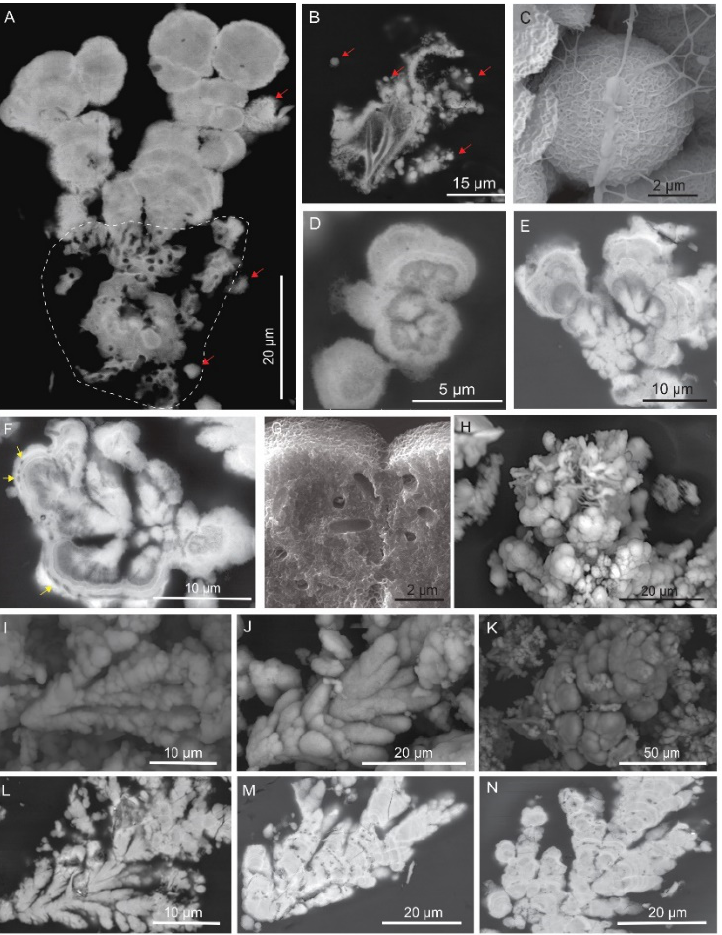
Figure 6. SEM images showing microstructures of the Ytterby rock wall Mn oxides. ( A ) Uncoated polished thin section showing laminated branches of dendritic-botryoidal Mn oxides growing on nucleation area (dashed). ( B ) Uncoated polished thin section of nucleation area showing Mn oxide encrustation of microbial remnants (filaments and cell-like structures) and wad-like Mn oxides occurring as solitary particles and in clusters (red arrows). ( C ) Cryo-SEM image showing nanometer thick sheets forming a reticulated surface texture of Mn oxide particle. ( D ) Cross section of wad-like Mn oxide particle. ( E , F ) Initial growth area capped by laminated Mn oxide precipitates. Note the embedded cell like structures (yellow arrows). ( G ) Cryo-SEM image showing cell-like structures embedded in microsperolitic/botryoidal Mn oxide microstructures ( H ) Filaments of varying thickness covering Mn oxides. ( I – M I; J; K; L; M; ) SEM images showing dendritic-botryoidal microstructures in the Ytterby Mn oxides. ( I – K I; J; K; ) Morphological continuity from thin shrub-like